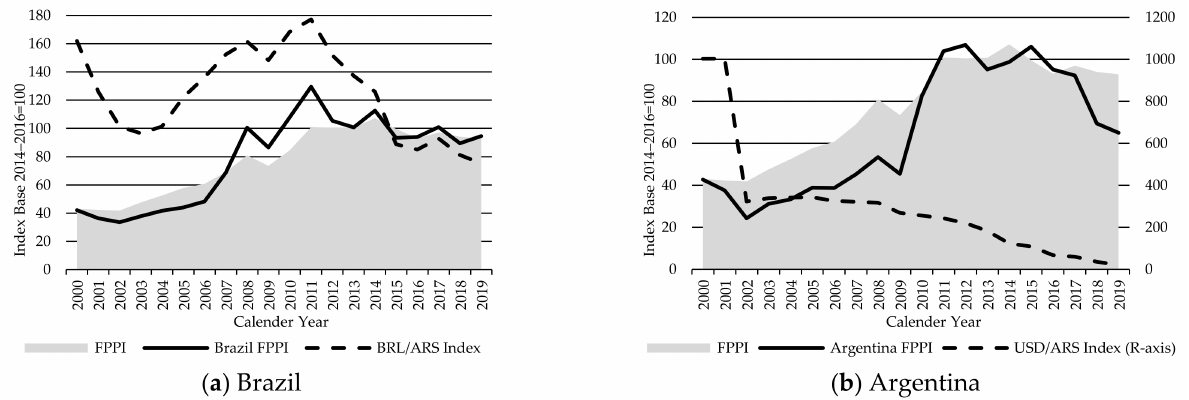
Figure 4. The Global Finished Cattle Producer Price Index FPPI vs. Brazil ( a ) and Argentina ( b ) Finished Cattle Producer Price Indices FPPIs and currency exchange indices, source: own